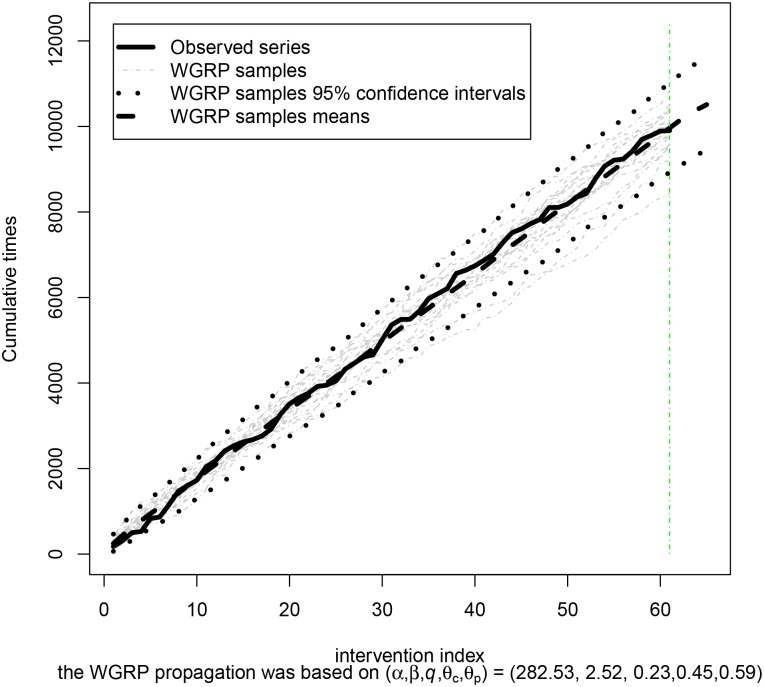
WGRP adjustment for Transformers.WGRP adjustment to the [21] Transformers data.